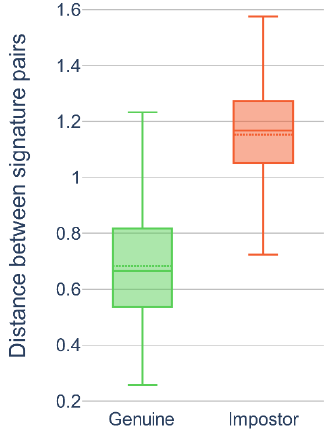
Figure 16. Boxplot of distances between signature pairs for “Genuine” and “Impostor” case evaluated on a small set containing skilled forgery attempts.